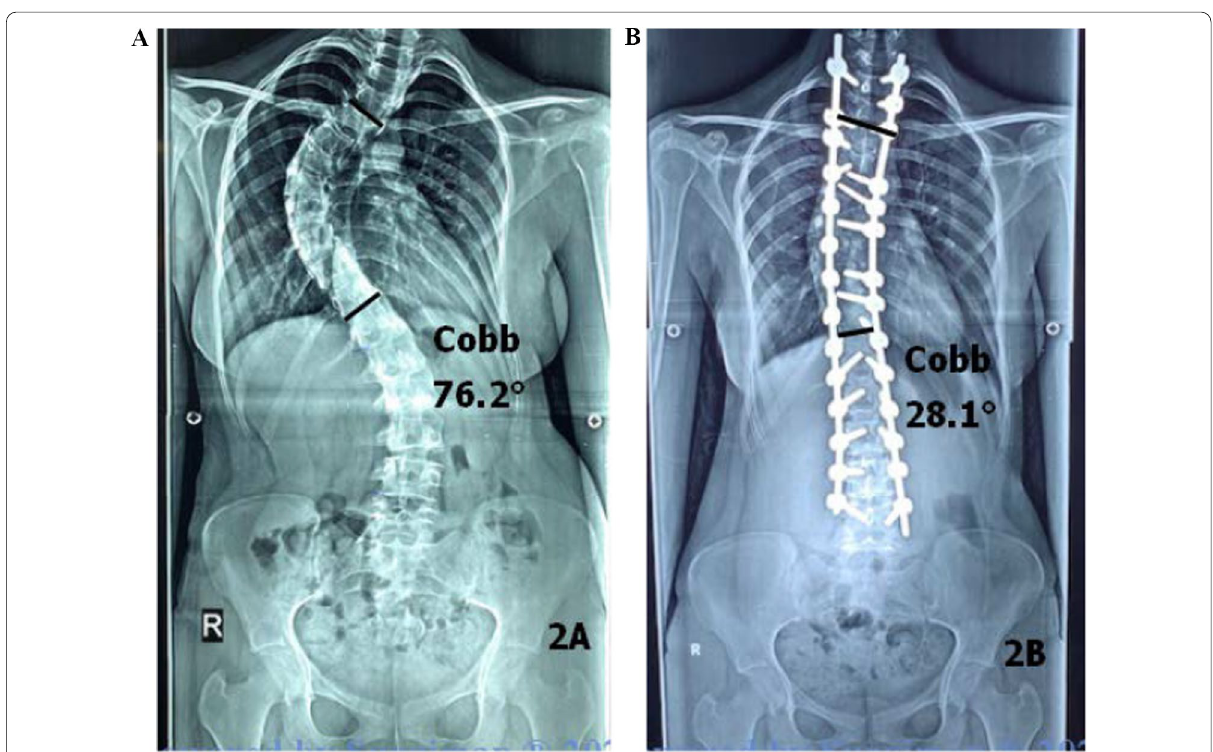
Fig. 2 A Plain X-ray (AP view) of the whole spine showing a main thoracic curve angle measures 76 degrees, in a 19-year-old female AIS Lenke type 1 A. B Postoperative plain X-rays (AP views) of the same case after 3 months showing correction of the main thoracic curve down to 28 degrees after Pvcr of the apex at